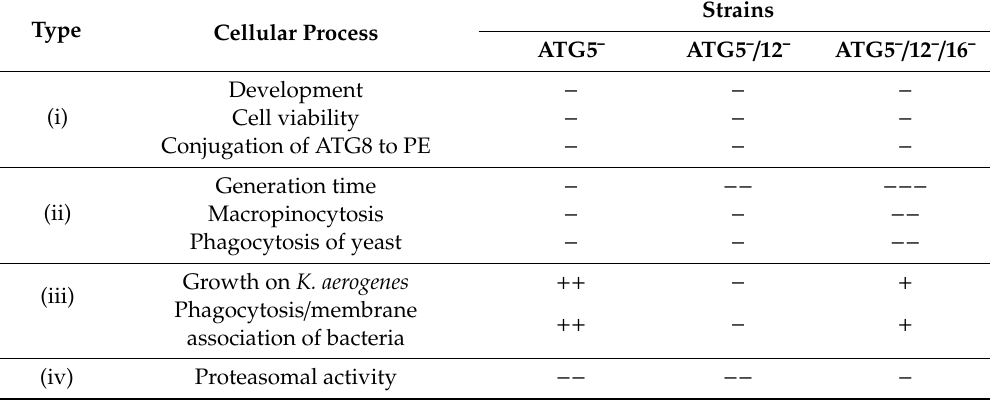
Table 2. Classification of phenotypes for di ff erent cellular processes for ATG5¯, ATG5¯ / 12¯ and ATG5¯ / 12¯ / 16¯ cells. “ + ” and “ − “ indicate an increase and a decrease, respectively, in the corresponding activity in the mutants in comparison to AX2 cells. Multiple “ + ” and “ − “ indicate the severity of the